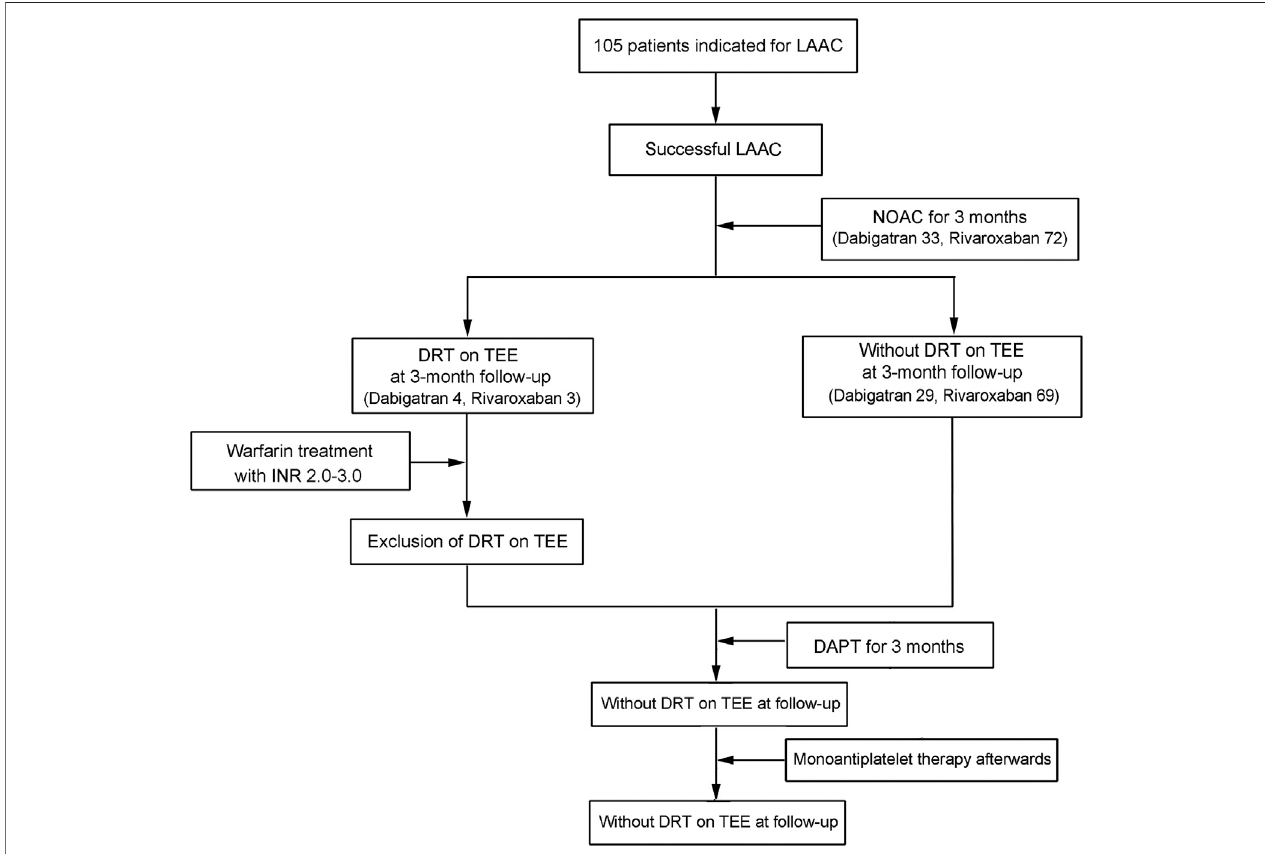
FIGURE 1 | Diagrammatic presentation of the sample size and progression in this study. NOAC, novel oral anticoagulants; DAPT, dual antiplatelet therapy; LAAC, left atrial appendage closure.